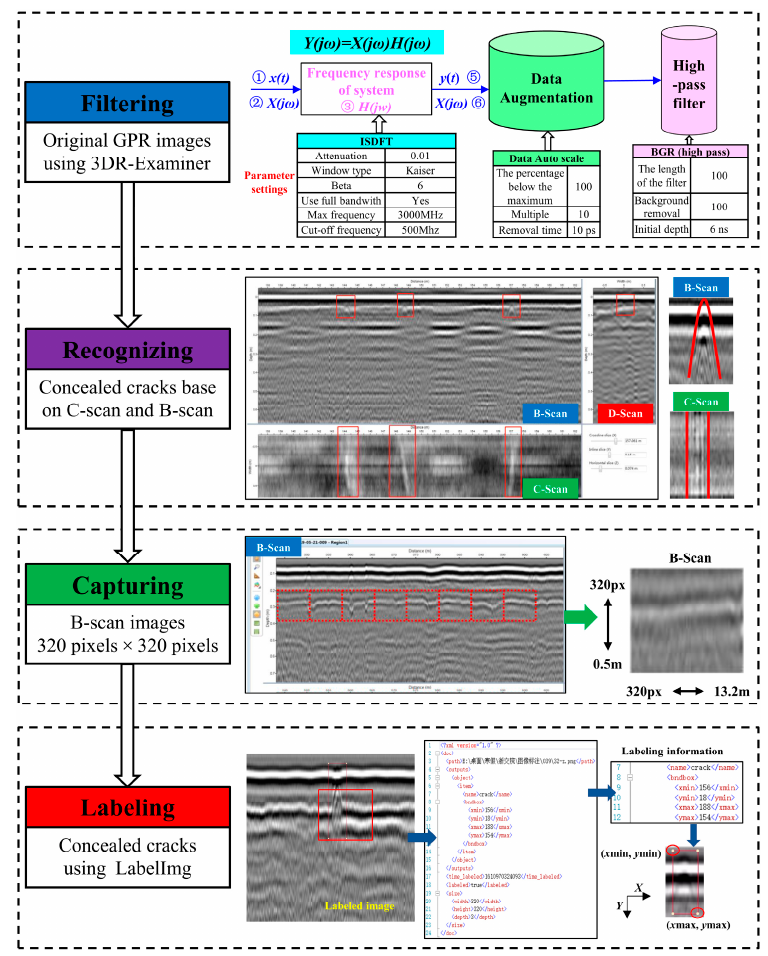
Figure 6. The workflow of dataset construction for GPR images [36].